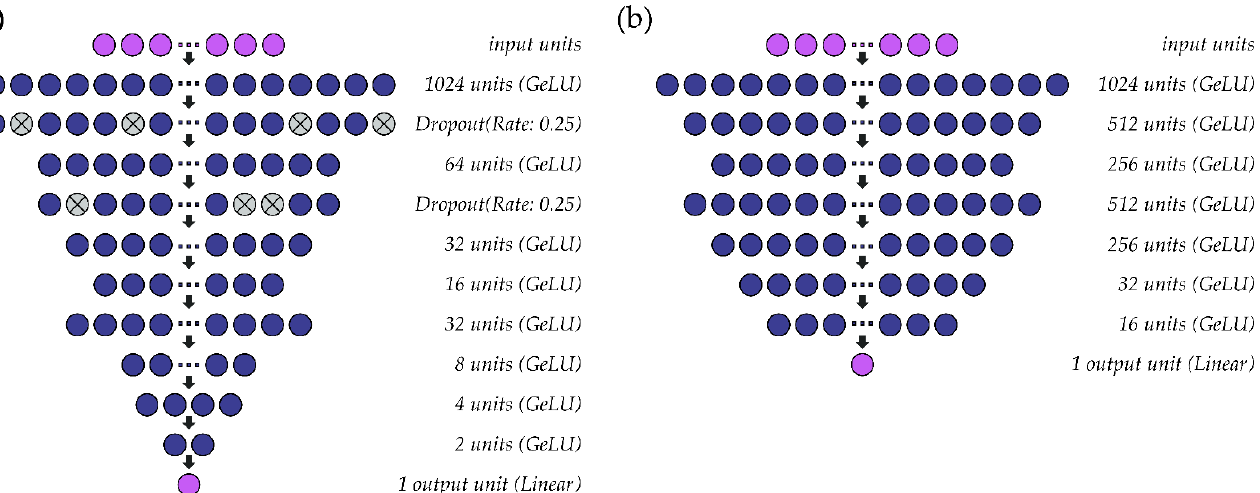
Figure 3. Structure of the multi-speaker deep regression neural networks used to estimate ( a ) f o and ( b ) intensity from sEMG signals.